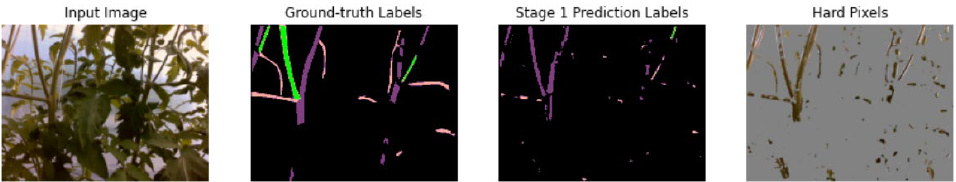
Figure 8. Result of stage 1. Hard Pixels image shows the pixels that stage 1 detected as difficult pixels, which will have more information added in stage 2. which will have more information added in stage 2. Table 1. Details of State